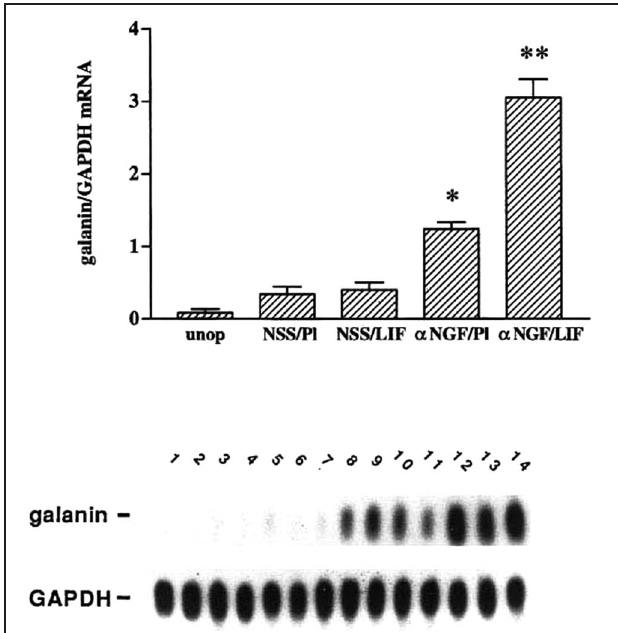
FIGURE 2 | Treatment with anti-NGF alters the responsiveness to LIF of intact sympathetic neurons in vivo . Messenger RNA levels were measured by northern blot analysis of SCG that were either untreated (unop), treated with NSS and a placebo pellet (NSS/Pl), treated with NSS and a LIF-containing slow-release pellet (NSS/LIF), treated with anti-NGF and a placebo pellet ( α NGF/Pl), or treated with anti-NGF and a LIF pellet ( α NGF/LIF). Treatment with antiserum or control serum was for three days, while with LIF pellets or control pellets were for two days. In the NSS/Pl group, there was only a small increase in galanin mRNA levels over the untreated group, probably due to a small amount of neural damage from desheathing the SCG which was done before pellet placement. Levels of galanin mRNA in the NSS/LIF group were not different from those in the NSS/Pl group. There was a 3.5-fold increase in galanin mRNA in the α NGF/Pl group as compared with NSS/Pl treatment. The α NGF/LIF group showed the highest levels of galanin mRNA in this experiment, being 2.3-fold higher than the α NGF/Pl group. Levels of galanin mRNA are expressed as a ratio of that of GAPDH in the same sample. The bar graph represents the means ± SEM of data from five or six samples per group with two SCG per sample. ∗ p , 0.0001 compared with NSS/Pl. ∗∗ p , 0.0001 compared with either NSS/LIF or α NGF/Pl. The autoradiograph is from one representative experiment and contains multiple lanes of the groups described above. Lanes 1 and 2, unop; lanes 3–5, NSS/Pl; lanes 6–8, NSS/LIF; lanes 9–11, α NGF/Pl; and lanes 12–14, α NGF/LIF. After the blot was probed for galanin, it was stripped and re-probed for GAPDH. The figure is from Shadiack et al. (1998).